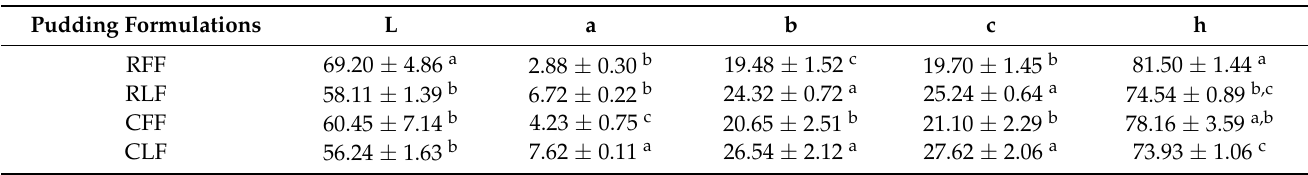
Table 4. CIELAB color spectra of pudding formulations (RFF—rice starch, peach pur é e; RLF—rice starch, lyophilized fruit; CFF—corn starch, peach pur é e; CLF—corn starch, lyophilized fruit). Pudding